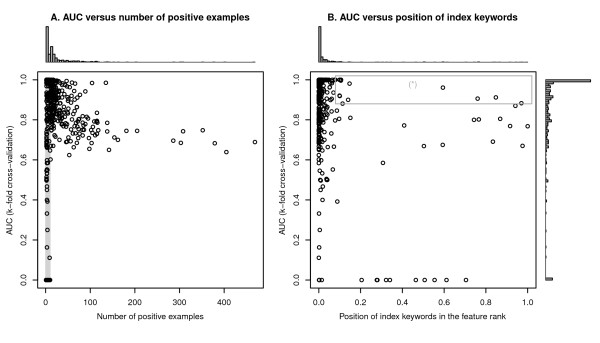
The predictive performance versus number of positive examples and the position of index keywords. This figure illustrates how the performance of BICEPP is related to the number of positive examples (A) and position of index keywords in the respective feature ranks (B). Each data point represents the best AUC (out of the 4 machine learning algorithms studied in this paper) performed on one of the 484 drug characteristics listed in Table 1. As illustrated in the shaded area in Figure 3(A), the predictive performance of BICEPP had a higher variability in datasets with less than 10 positive examples. The boxed area (*) in Figure 3(B) represents a list of "surprising characteristics", whose predictive powers were high but the index keywords were not discriminative. The contents are listed in more detail in Table 3. Refer to the main text for details.